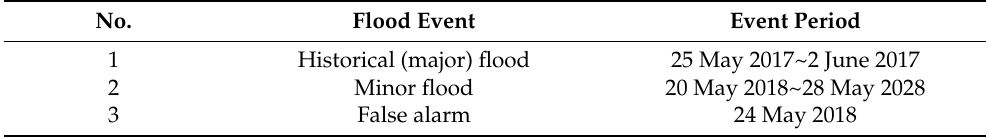
Table 2. The selected flood events for the system performance